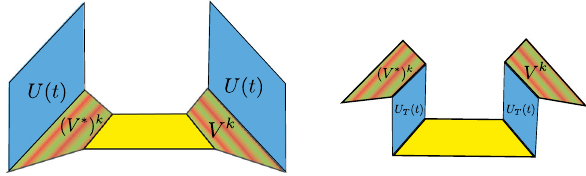
Fig. 19 Illustration of a tensor network constructing the TFD state and its time evolution